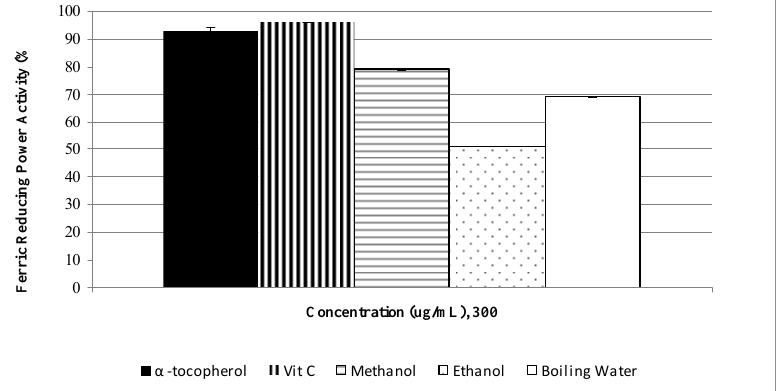
Figure 4. The reductive potential of C. sativus L. stigma extracts and reference antioxidants at 300 μ g/mL.